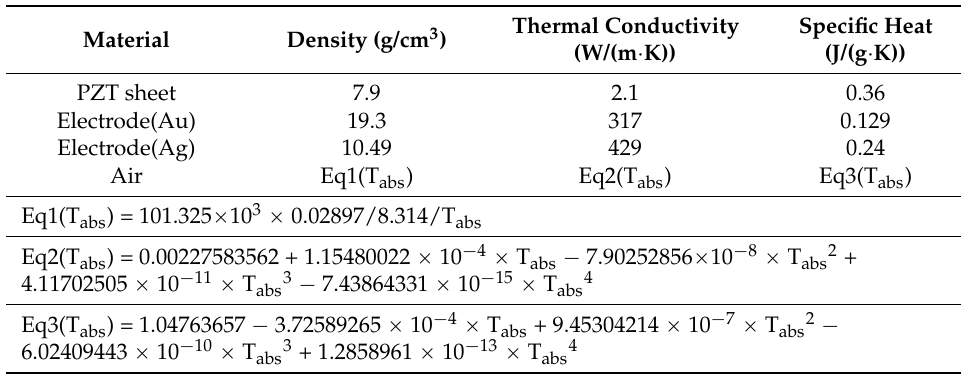
Table 2. Material parameters for finite element analysis.